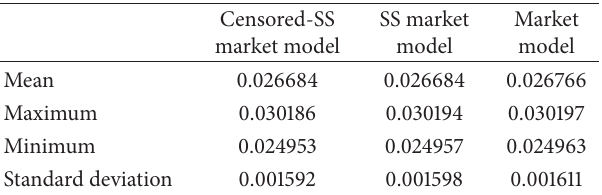
Table 7: The statistics of RMSE within